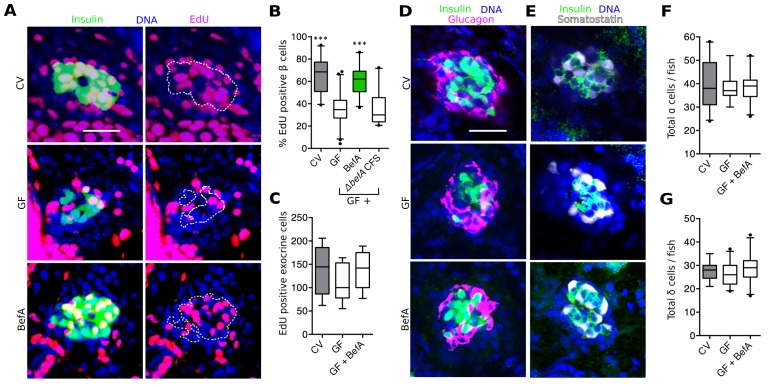
BefA facilitates β cell mass expansion through proliferation.(A, D & E) Representative 2D slices from confocal scans through the primary islets of GF, CV and BefA (10165) protein treated 6 dpf larvae. Scale bars = 40 μM. (A) Insulin promoter expressing β cells are shown in green, all nuclei are blue, and EdU containing nuclei are magenta. Left hand panels are a merge of all three markers. For ease of resolving cells that are double positive for both insulin and EdU, the right hand panels show the location of insulin outlined by white dashed lines. (B) Percentage of EdU positive β cells in CV, GF or GF treated with either purified BefA or CFS from A. veroniiΔbefA cultures (△befA CFS). ***p<0.001: Denotes treatment that is significantly different than GF by Tukey analysis. (C) Total EdU positive exocrine cells quantified from the approximate central longitudinal plane of the pancreas in each fish. (D) Insulin promoter expressing β cells are shown in green, all nuclei are blue, and α cells, stained with anti-glucagon antibody are magenta. (E) Somatostatin promoter expressing δ cells are shown in white, all nuclei are blue, and β cells stained with anti-insulin antibody are outlined in green. (F) Total α cells in GF, CV and GF fish treated with BefA. (G) Total δ cells in GF, CV and GF fish treated with BefA.DOI:
http://dx.doi.org/10.7554/eLife.20145.01610.7554/eLife.20145.017Figure 5—source data 1.Quantifications and statistical analysis of proliferation of larval β cells corresponding to Figure 5B.Exact values of N, mean, median, SD, and SEM are reported in the source data file and are highlighted in yellow, magenta, blue, green, and cyan, respectively.